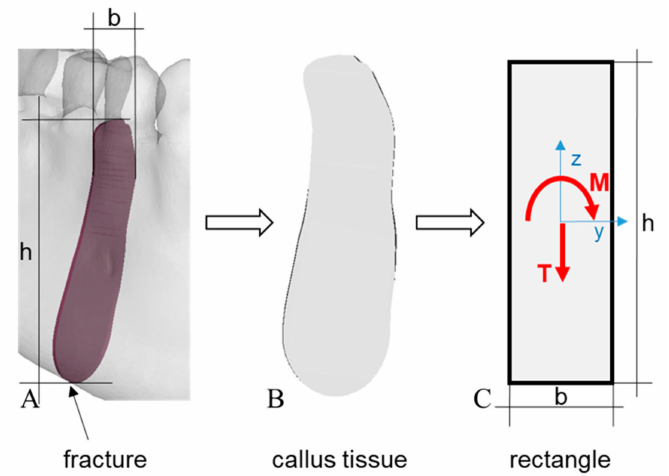
Figure 1. The mandible cross-section for the fracture modeling ( A ) and the callus tissue ( B ) simplified to a rectangular cross-section ( b × h ) ( C ), which is loaded with the bending moment (M) and shear force